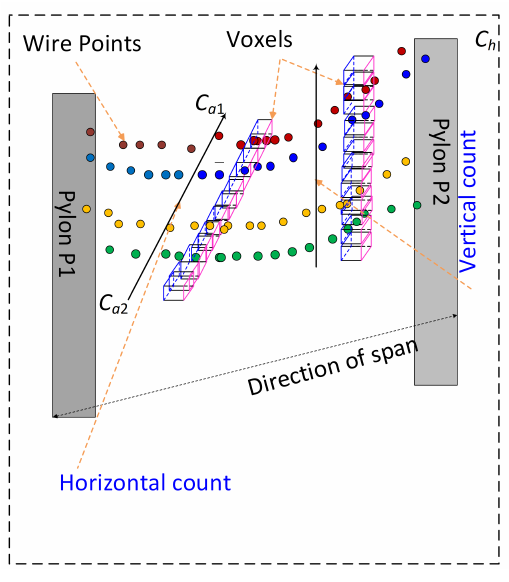
Figure 3. Wires labelling.